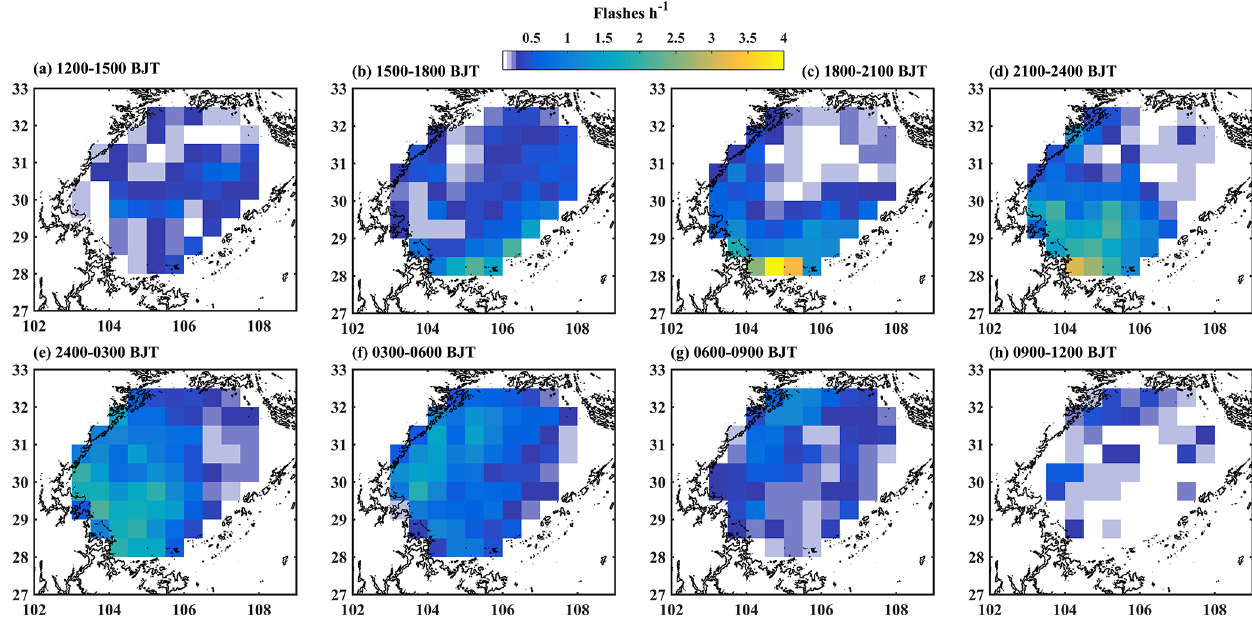
Figure 4. Diurnal cycle of lightning flashes (unit: flashes h − 1 ) on a 0 . 5 ◦ × 0 . 5 ◦ grid with an interval of 3h (BJT) for 2010–2018 including the summer months (June, July, and August). The 1500m altitude line is shown with black lines to highlight the location of the basin.